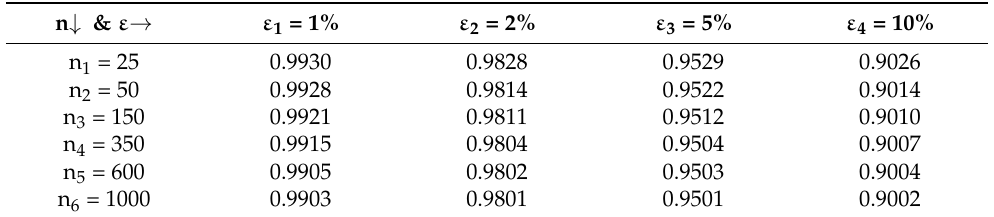
Table 11. Simulation results for the empirical levels versus the corresponding theoretical levels for 𝜀 = 1%; 2%; 5%; 10% and 𝑁 = 12,000 .